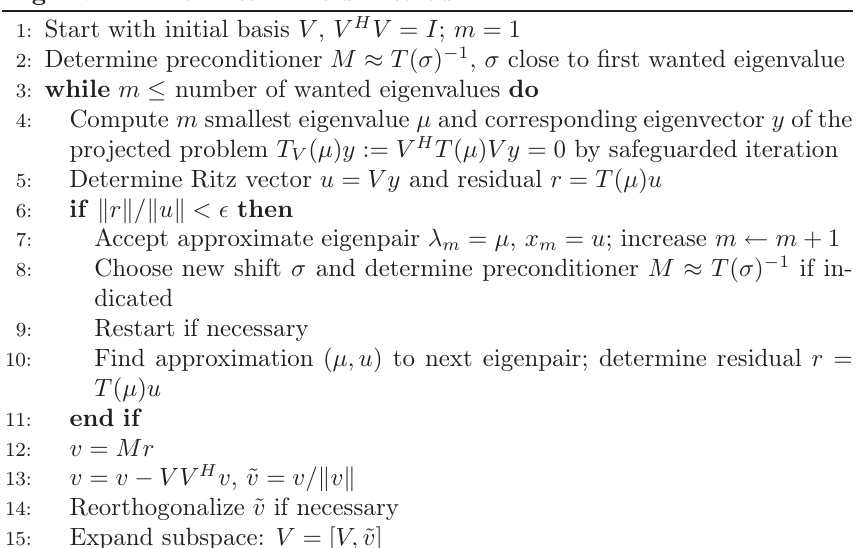
Algorithm 2 Nonlinear Arnoldi